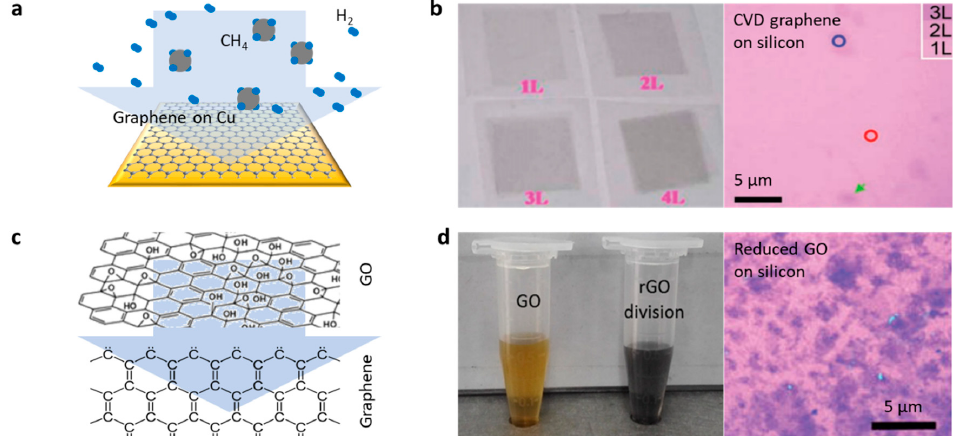
Figure 5. Graphene fabrication. ( a ) Graphene grown by using chemical vapor deposition (CVD) method. ( b ) Pictures of graphene samples fabricated by using CVD method. ( c ) Graphene reduced from graphene oxide (GO) in liquid. ( d ) Picture of GO and reduced GO (rGO) dispersions, and the deposited reduced GO film on silicon substrate. Pictures in ( b ) are reproduced from Refs. [71,72]. Figure 6a. Figure 6b sketches the fabrication flows of a graphene-based fiber structure by using CVD technique [41]. For graphene attached on microfibers, graphene is transferred to a low refractive index substrate; afterwards, microfibers are put on the graphene, kept contacted. Such a van der